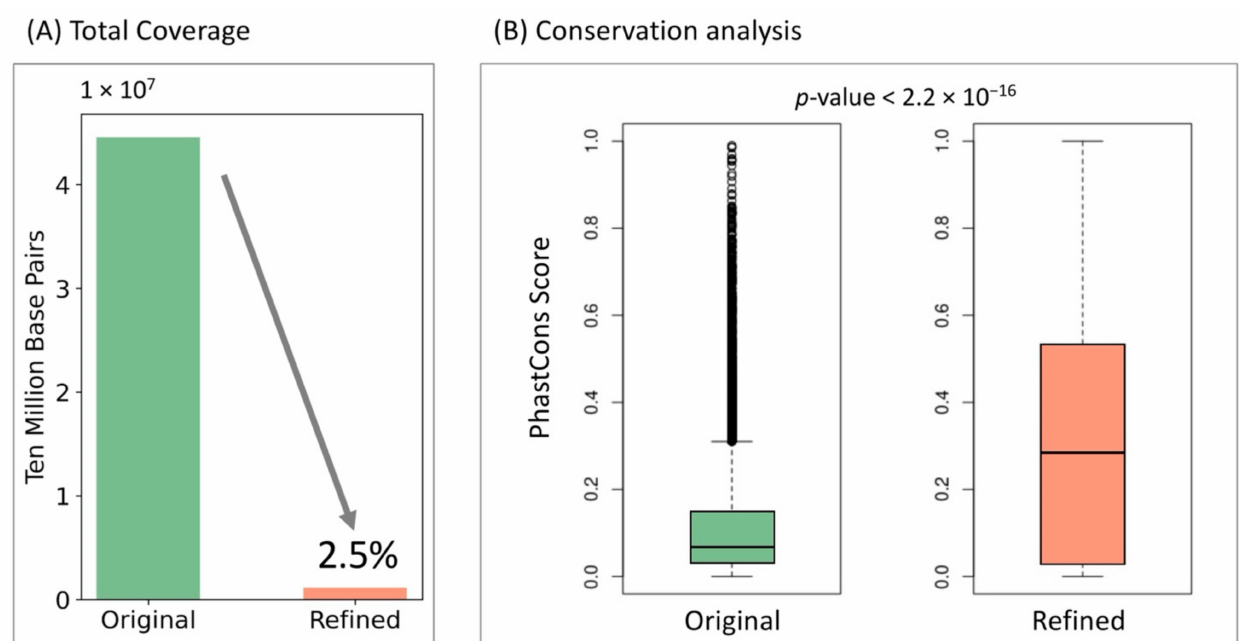
Figure 5. ( A ) Total nucleotide coverage of the original insulator annotations compared with Insu- Lock’s refined insulator annotations. ( B ) Conservation analyses using PhastCons score indicate that the refined regions are significantly conserved compared to original